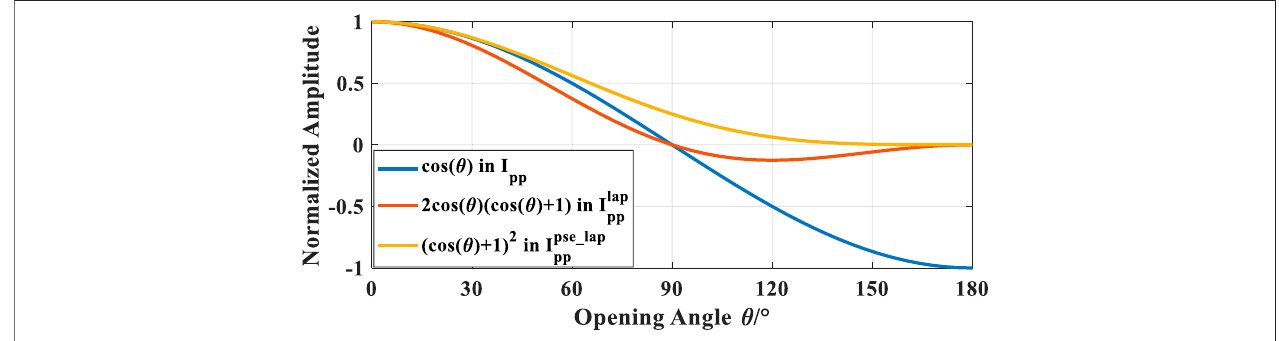
FIGURE 6 | The variation of a weighting factor in the scalar imaging condition, the scalar imaging condition with a Laplace fi lter and with a pseudo-Laplace fi lter. Note that the blue curve of the weighting factor cos θ will cross through the axis whose amplitude is zero and reach -1 while the opening angle is 180 + . The red curve of the weighting factor 2 cos θ (cos θ + 1) goes through the axis whose amplitude is zero and reaches 0 while the opening angle is 180 + . The yellow curve of the weighting factor (cos θ + 1) 2 range 1 – 0 without change of positive and negative